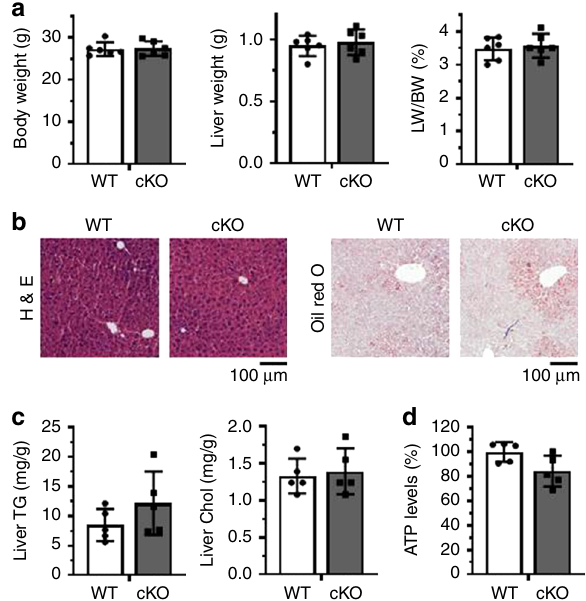
Fig. 1 Deletion of HuR in the liver does not alter hepatocyte phenotype of liver function. a Conditional hepatocyte-speci fi c HuR knockout mice (cKO, n = 6) and wild-type littermates (WT, n = 6) were used for analyzing body weight, liver weight, and the ratio of liver/body weight. b Representative images of hematoxylin and eosin (H&E) and Oil Red O staining of liver slices from the mice described in a (WT, n = 5; cKO, n = 5). c , d Livers from mice described in a were used for analyzing the levels of triglyceride (TG) and cholesterol (Chol) ( c ) (WT, n = 5; cKO, n = 5), and the levels of ATP ( d ) (WT, n = 5; cKO, n = 5). Data are the means ± SD. All the error bars are equivalent throughout the fi gure. Source data are provided as a Source Data fi